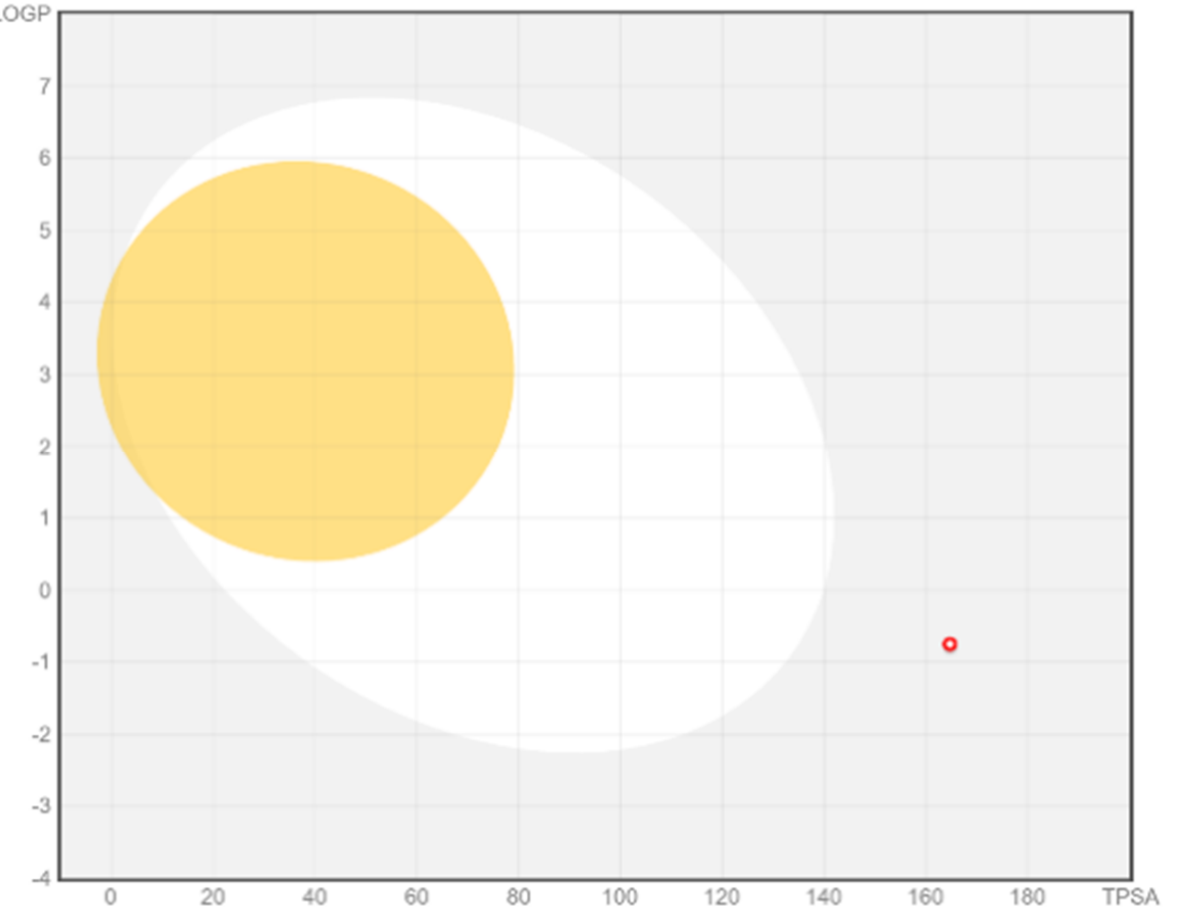
Figure 16. BOILED-Egg image of chlorogenic acid. The yellow region shows a high probability of brain penetration, the white region shows high permeability of passive absorption by the gastrointestinal tract and the red dot shows that compound that is not the substrate of P-gp.